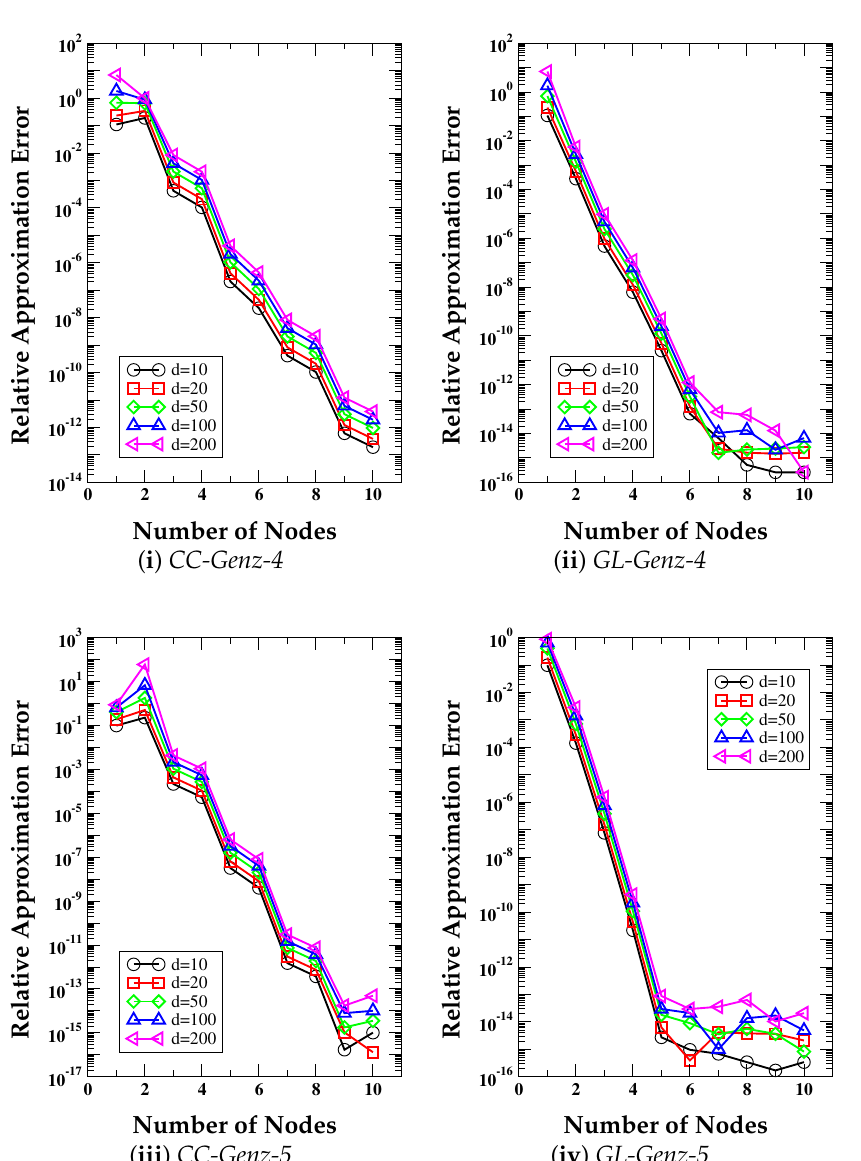
Figure 5. Test Case 4. Relative approximation error curves versus the number of integration nodes m of the univariate quadrature rule for the numerical integration of a d -dimensional Gaussian bell- shaped function (Genz-4, top panels) and the exponential function (Genz-5, bottom panels). We integrate both multidimensional functions on a 2 d grid with d = 10,20,50,100,200. In panels ( i )